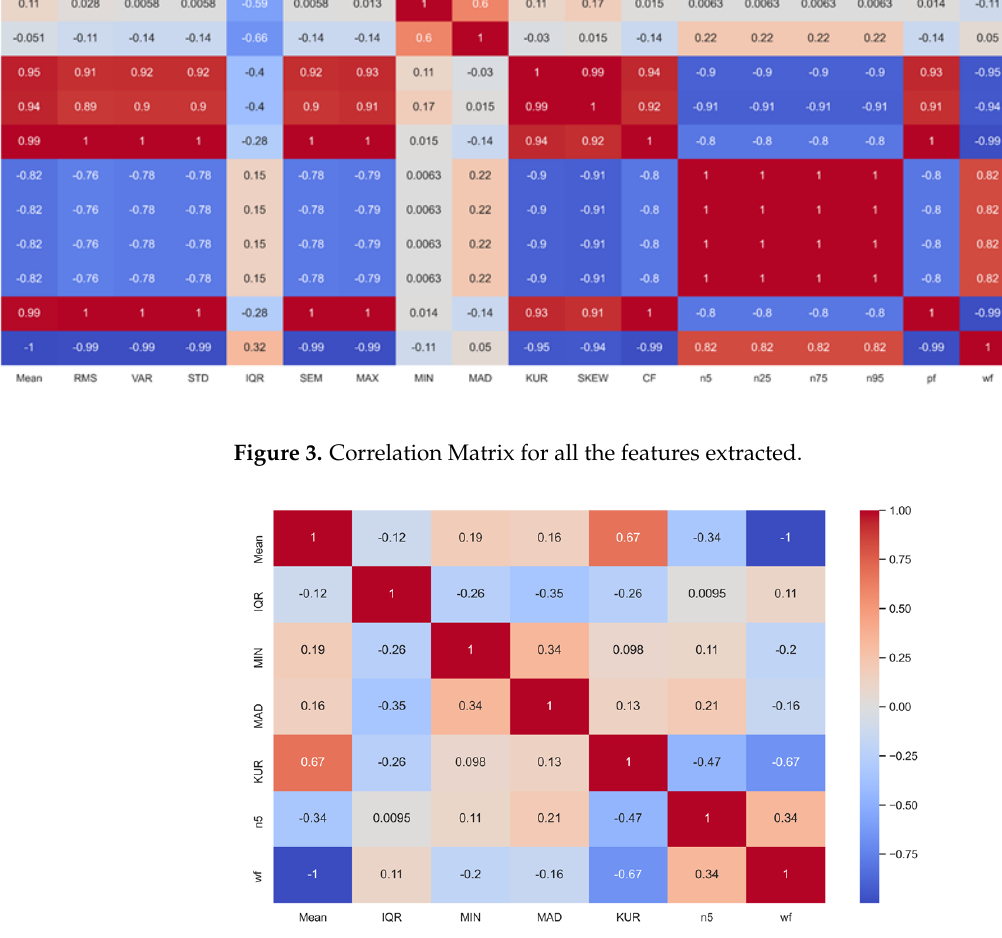
Figure 4. Correlation Matrix for the features